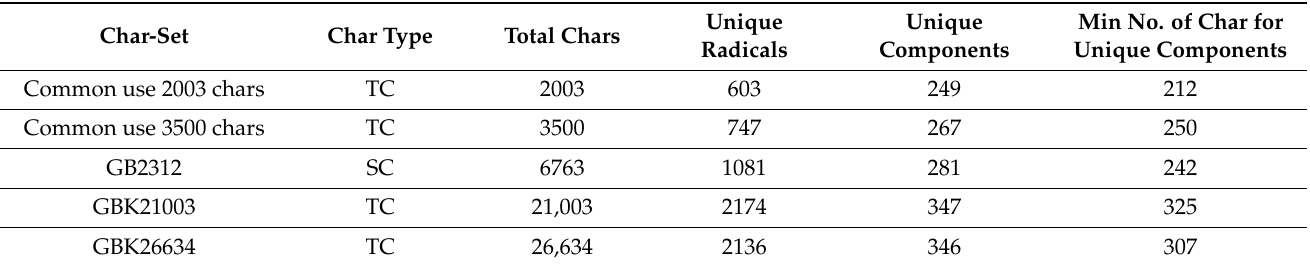
Table 1. Radicals and components of character sets.